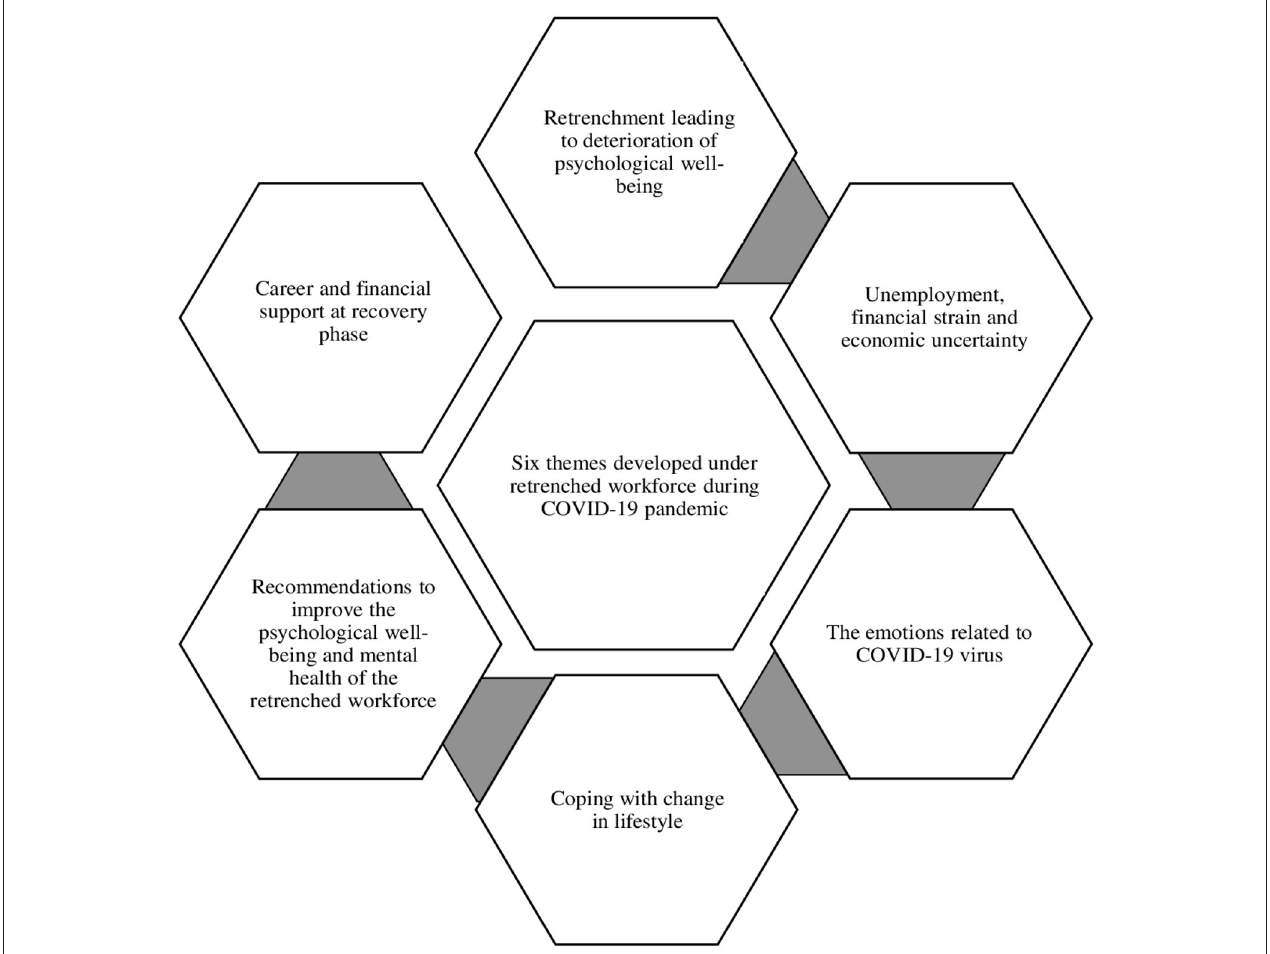
FIGURE 2 | Diagram illustrating inter-connected themes related to retrenched